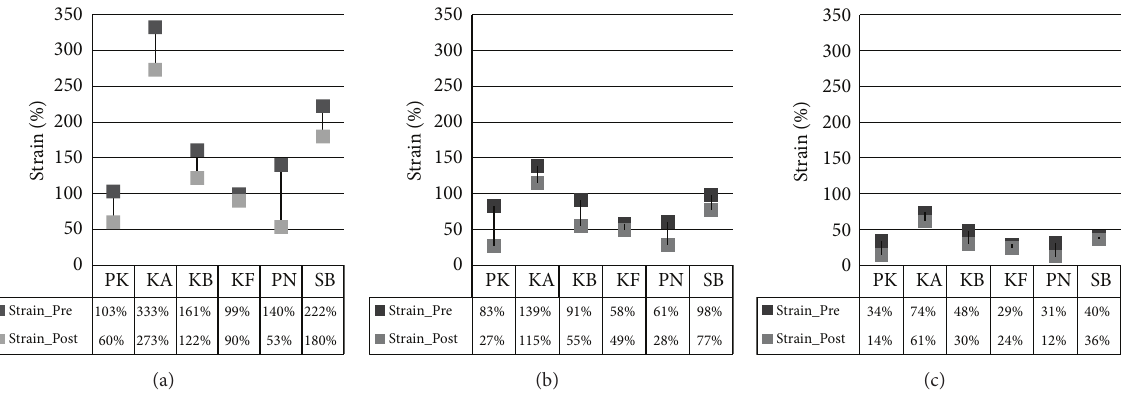
Figure 7: Diagram of average strain levels at the lateral ventricle (a) CC fiber (b) and CS fiber (c) for all the 6 patients. The horizontal axis is the patient’s identification (id), and the vertical axis shows the strain levels for the corresponding patient at precraniotomy stage (Strain Pre with darker gray color) and postcraniotomy stage (Strain Post, with lighter gray color). The exact strain level values are presented in the